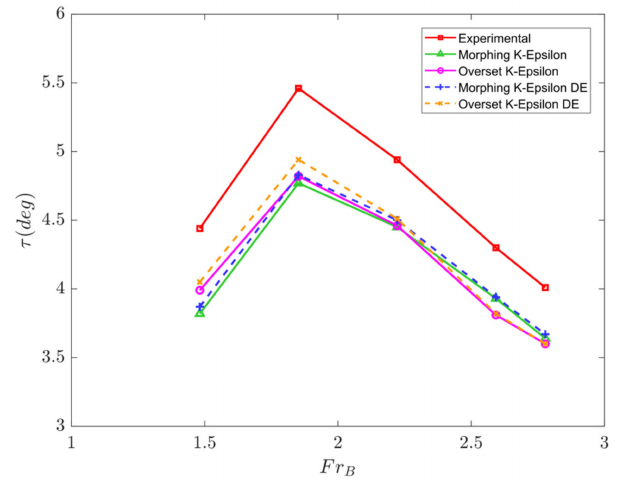
Figure 8. Comparison of the numerically computed values of trim angle against laboratory measure- ments of De Luca [13].